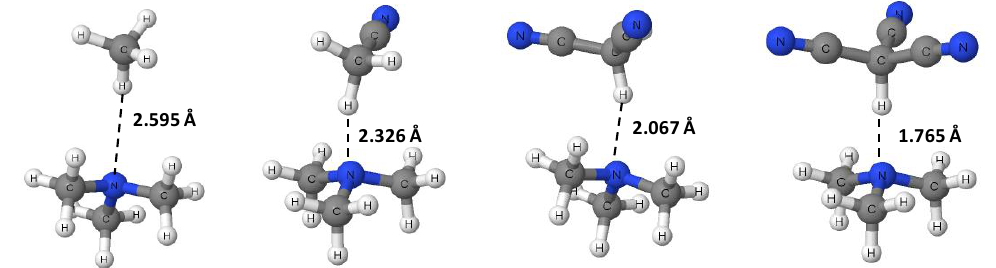
Figure 1. ω B97X-D/aug-cc-pVTZ-optimized geometries of the CH 3 − n (CN) n H ··· NMe 3 (n = 0–3) complexes.